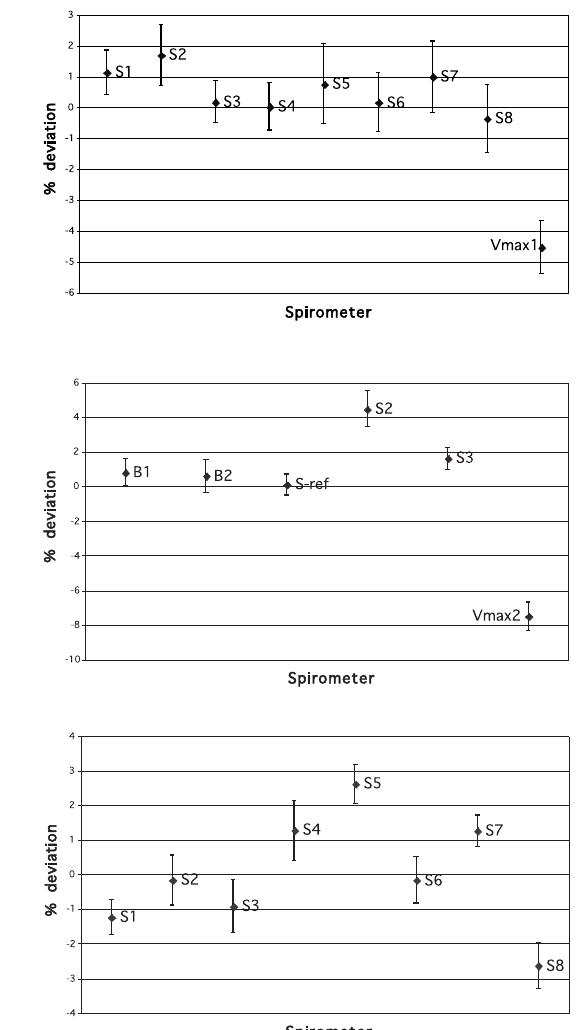
Device-specific mean (and 95% CI) devia- tion in percent from personal mean FVC calculated across results taken at all devices in test series